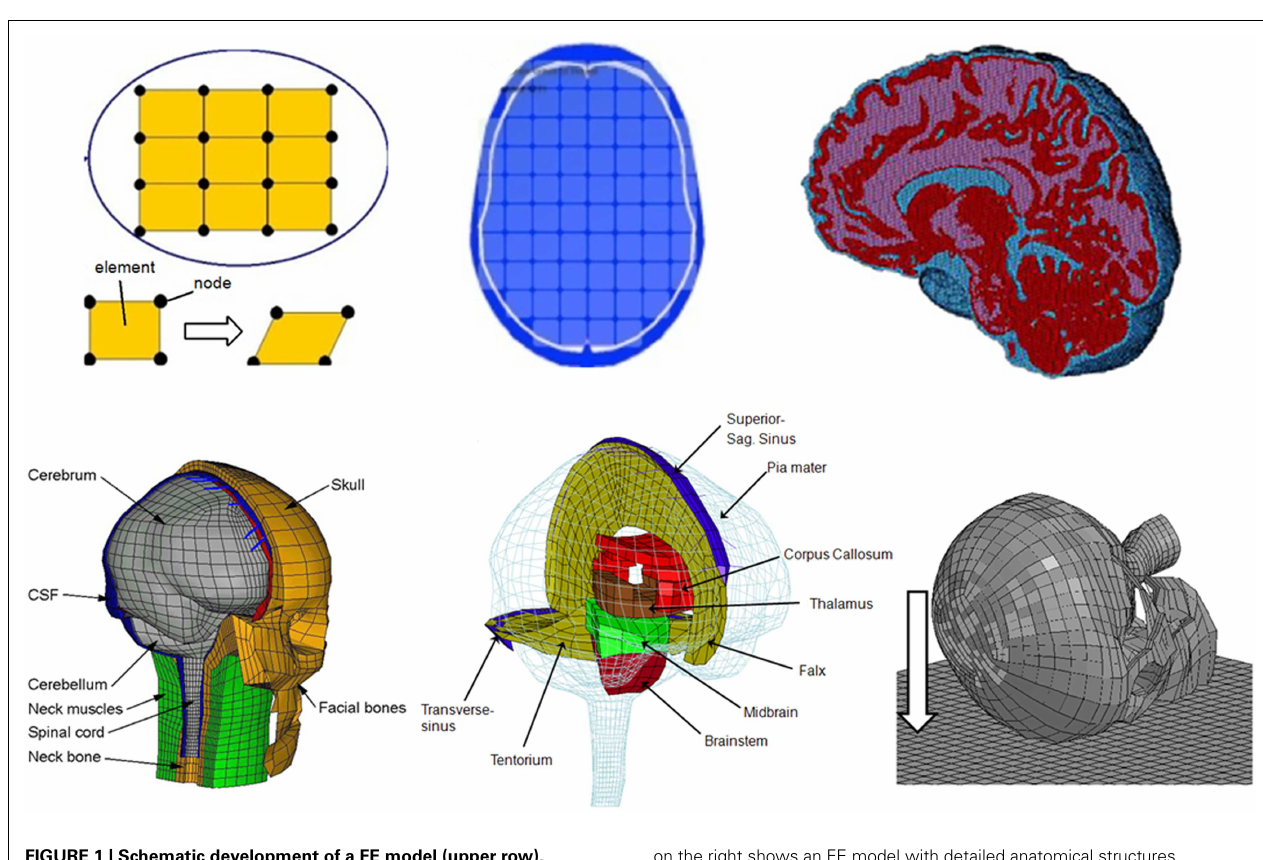
FIGURE 1 | Schematic development of a FE model (upper row). The pictures illustrate the concept of FE model development procedure. First, a continuum is discredited by a number of finite elements connected at their common nodes.The picture in the middle shows an axial slice with elements included, and the picture